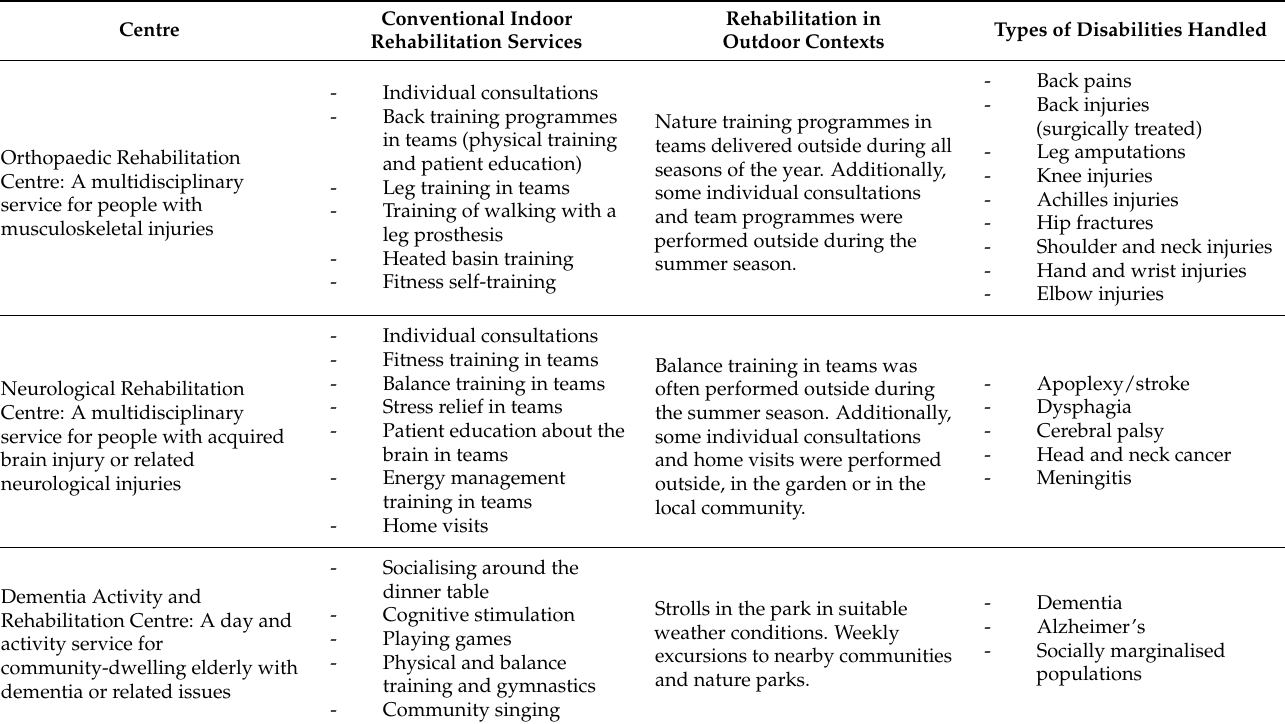
Table 1. Characteristics of the included rehabilitation centres